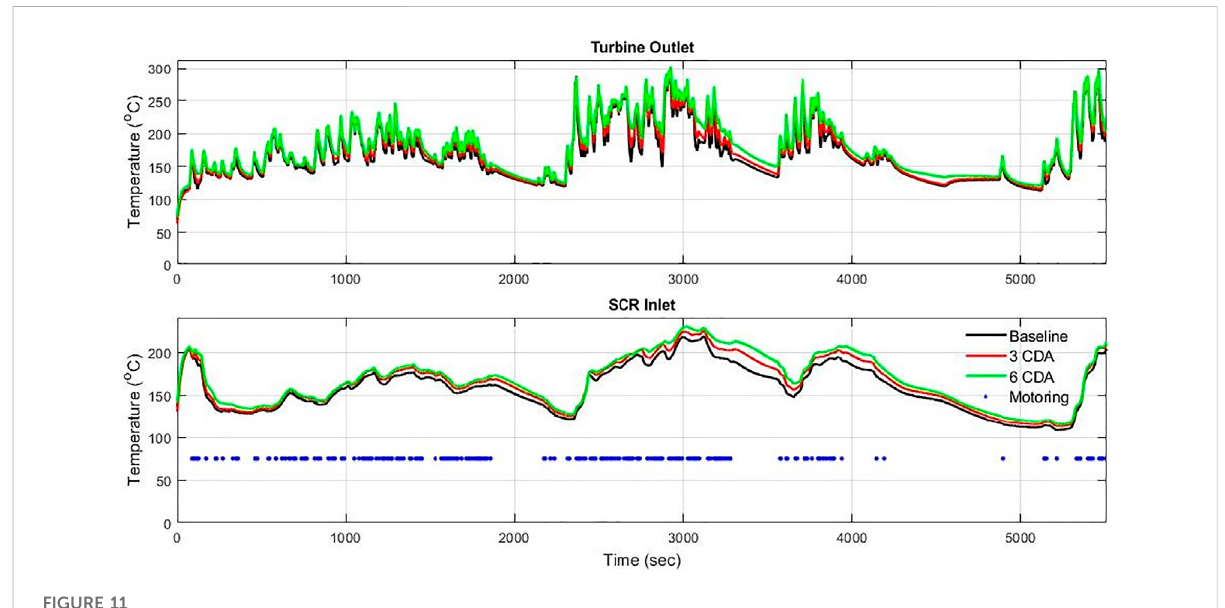
FIGURE 11 CARB LLC exhaust temperature pro fi